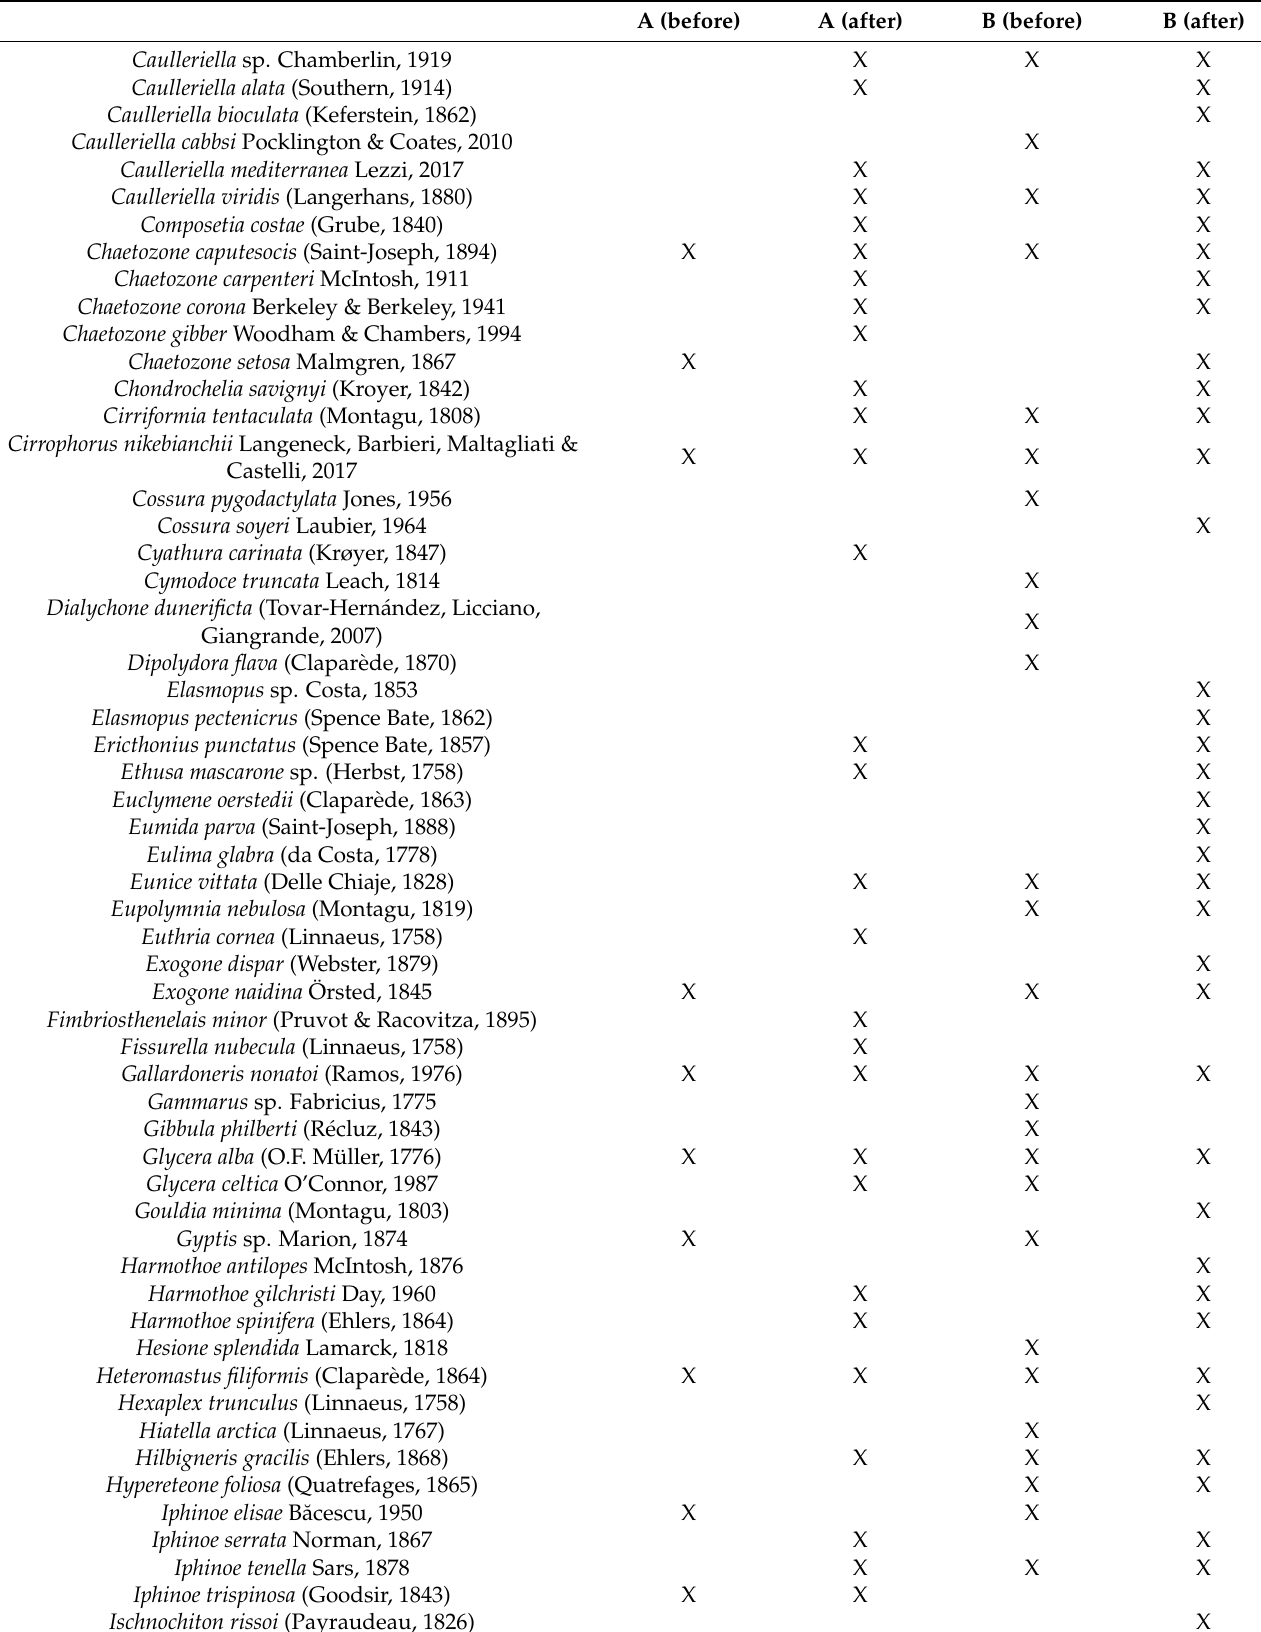
Table A1. Cont. A (before) A (after) B (before) B